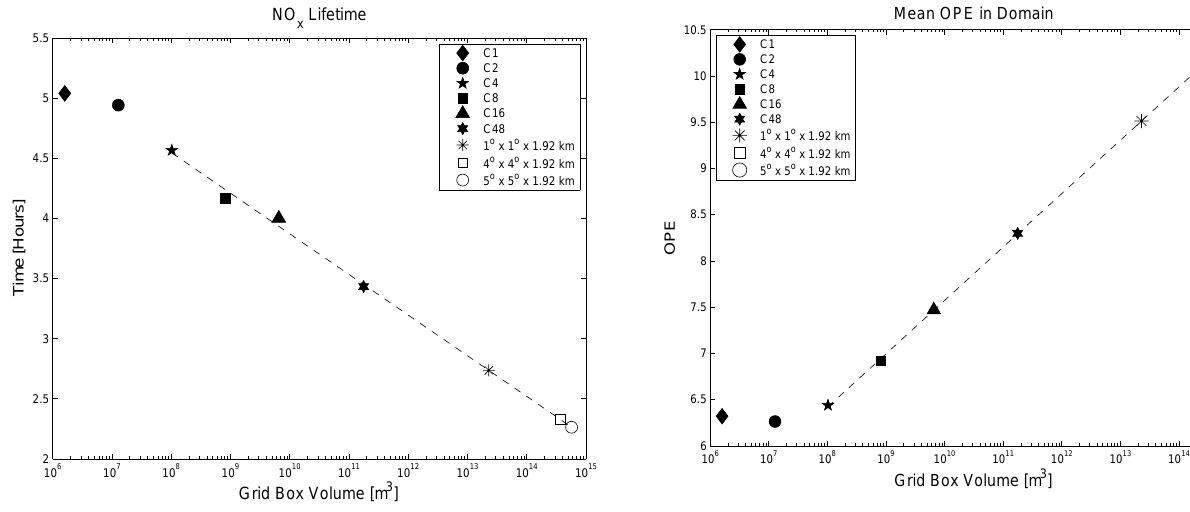
Fig. 6. Mean NO x lifetime, (defined as the ratio of domain total rate of production of HNO 3 to domain total NO x ), at noon (local time) on day 2 for different resolution domains. Dashed line represents best fit to the model results C4, C8, C16 and C48. Extrapolation as in Fig. 5. For comparison, the clean model run produces a domain mean NO x lifetime of 6.4h at the same time.